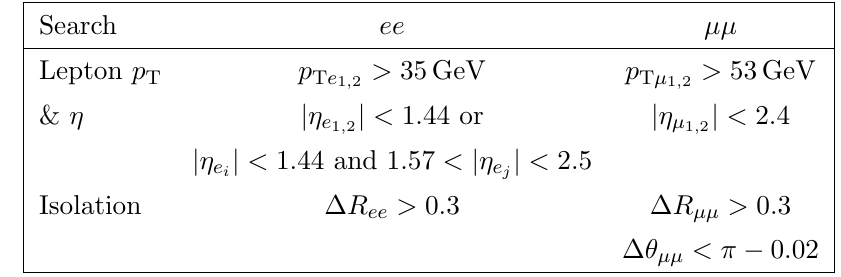
Table 4. Summary of selection cuts for the CMS Drell-Yan ee and (cid:22)(cid:22) search